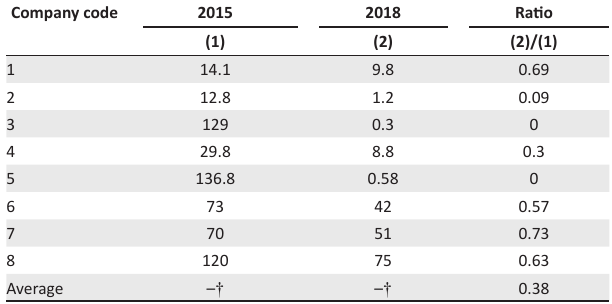
TABLE 7: Change in lead time in the targeted production line before (2015) and after (2018) Kaizen training (hours). Company